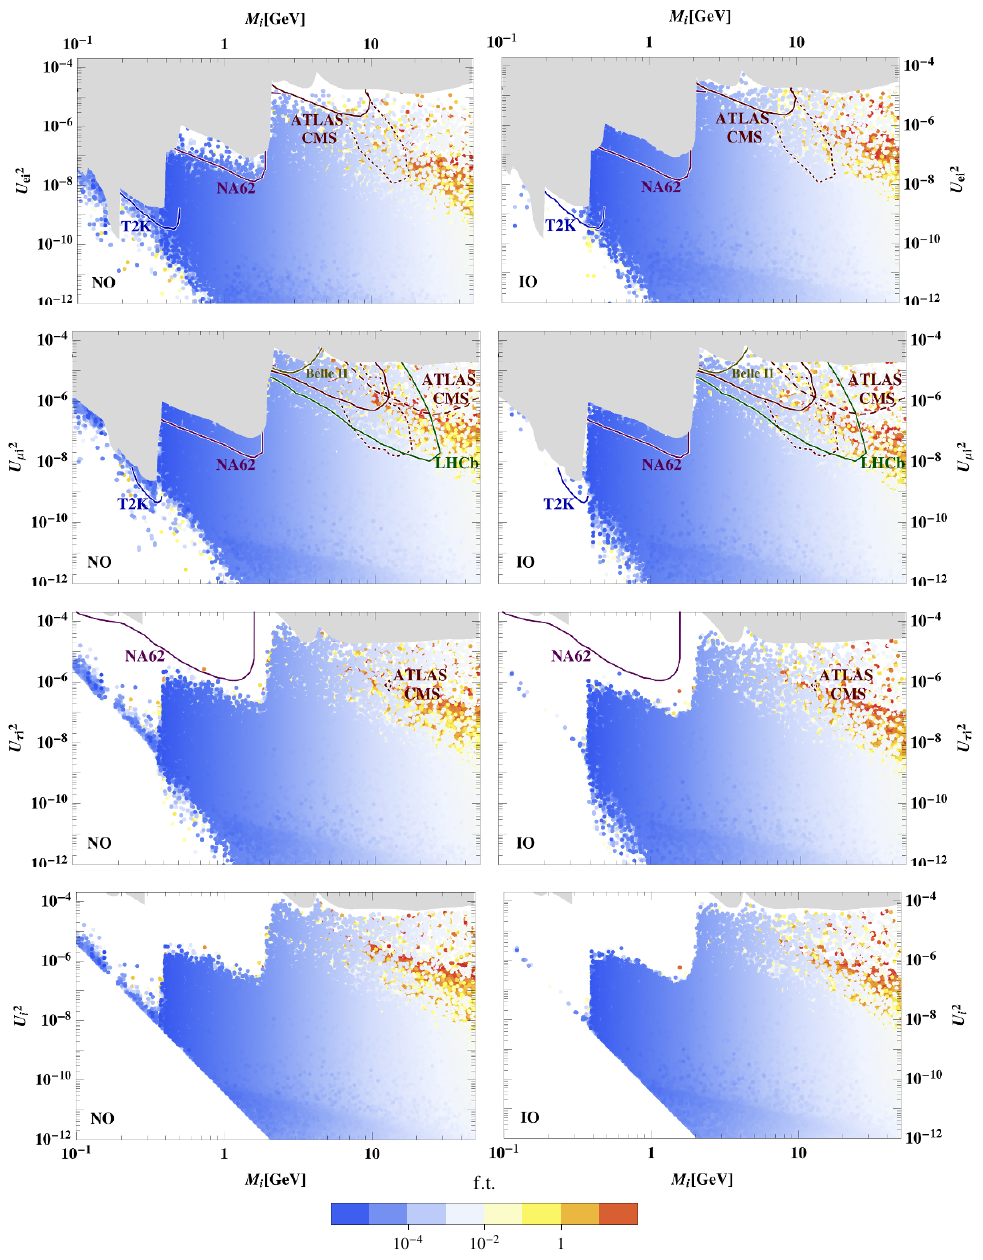
Figure 1 . Active-sterile mixing for the viable BAU solutions as a function of the heavy neutrino mass, for a normal (left) and an inverted (right) ordering in the light neutrino mass spectrum. From top to bottom: electron U 2 , muon U 2 , tau U 2 and summed U 2 mixings. The grey region is ei (cid:22)i (cid:28)i i excluded by direct searches of heavy neutral leptons (cf. section 5.2), the lines show the expected sensitivities for the ongoing experiments T2K [182], NA62 [39], Belle II [183], LHCb [180] with an integrated luminosity of 380 fb (cid:0) 1 , and for ATLAS and CMS with an integrated luminosity of 300 fb (cid:0) 1 . The latter include di(cid:11)erent proposed searches: [22] (continuous line), [17] (dashed line), [21] (dotted line).